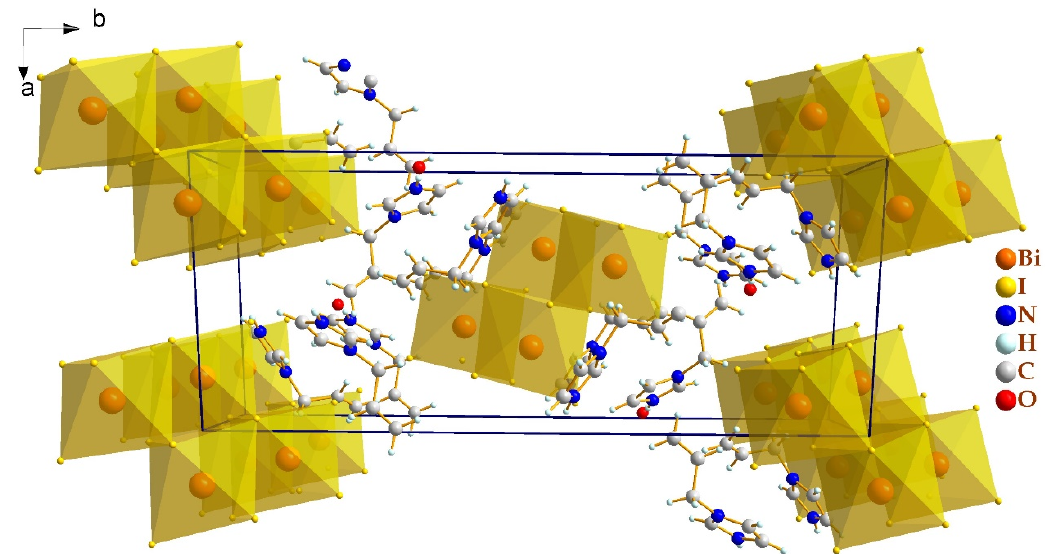
Figure 2. The (110) view of the crystal packing in Bi 4 I 16 ·4(C 6 H 9 N 2 )·2(H 2 O).